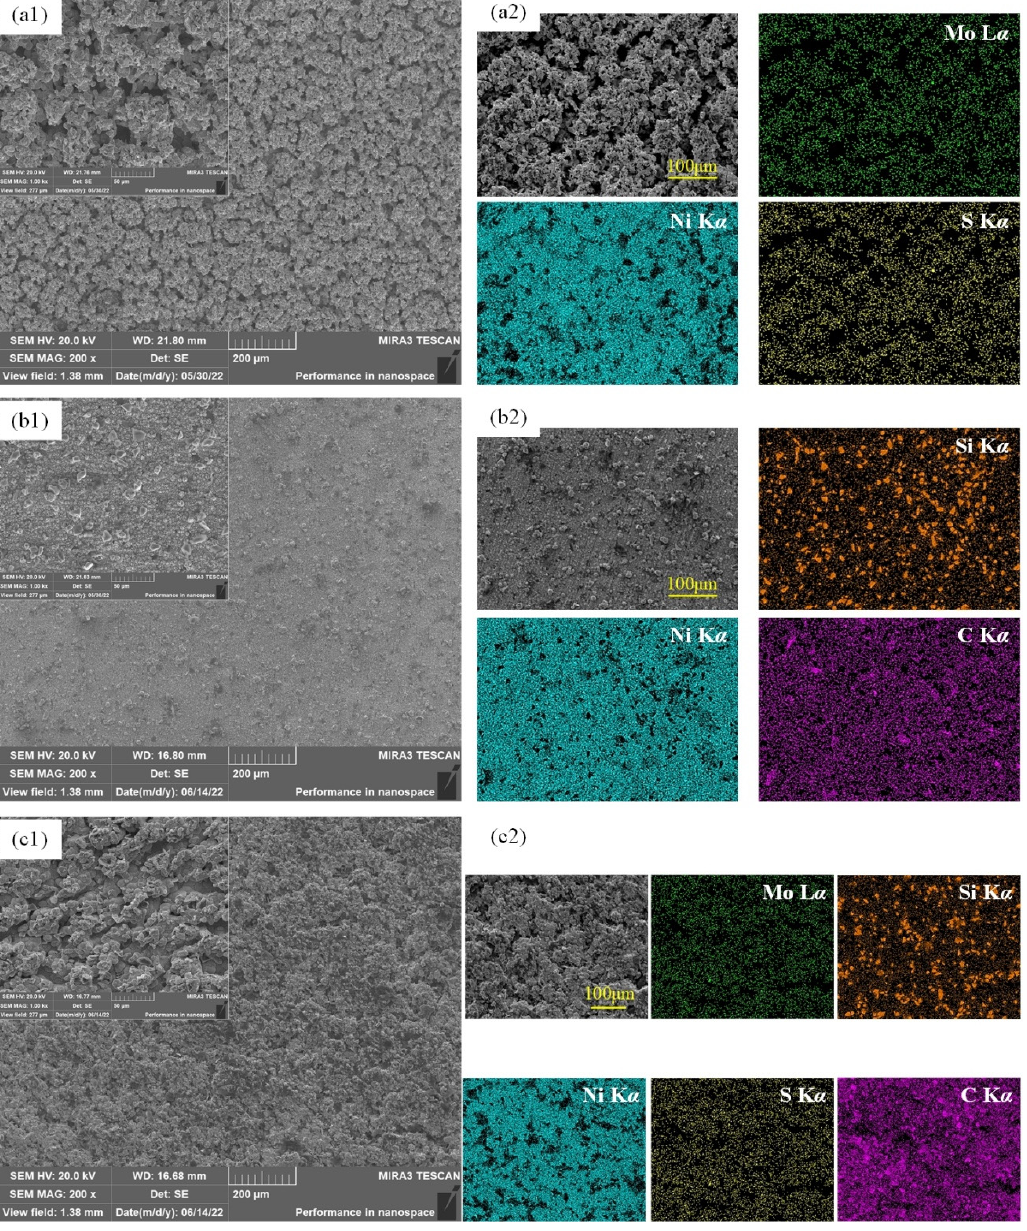
Figure 3. SEM images and EDS mappings for composite coating samples. ( a1 , a2 ) E1 sample; ( b1 , b2 ) E2 sample; ( c1 , c2 ) E3 sample. E2 sample; ( c1 , c2 ) E3